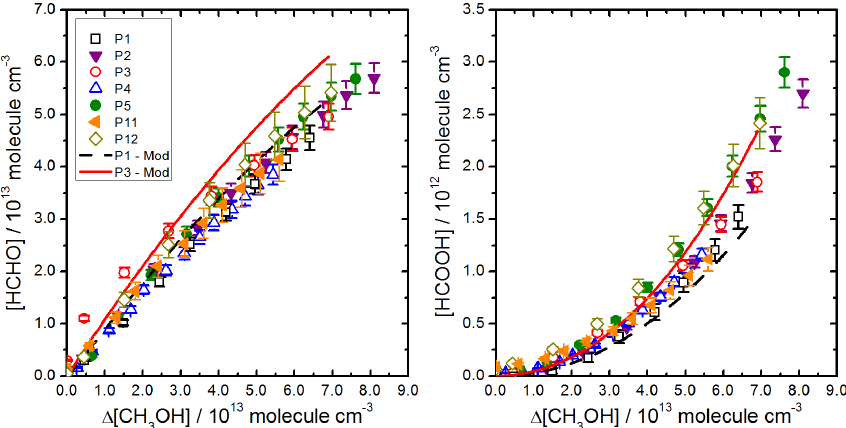
Figure 4. The [HCHO] (left) and [HCOOH] (right) profiles as a function of (cid:49) [CH 3 OH] for experiments P1–P5, P11 and P12, for [CH 3 OH] 0 :[CH 3 CHO] 0 ≈ 3 . 8 at 1000mbar and 293K. Good agreement was observed between experimental data and the chemical model for all data sets with k (R5) = 2.4 × 10 − 11 cm 3 molecule − 1 s − 1 and average determined yields of α (R5a) = 0.37 ± 0.10, α ( R5b ) = 0.12 ± 0.04 and α (R5c) = 0.51 ± 0.12. Only model runs for experiments P1 and P3 are plotted as examples, the optimised (Reaction R5) branching ratios thereof are shown in Table 1. All uncertainties quoted to ± 1 σ